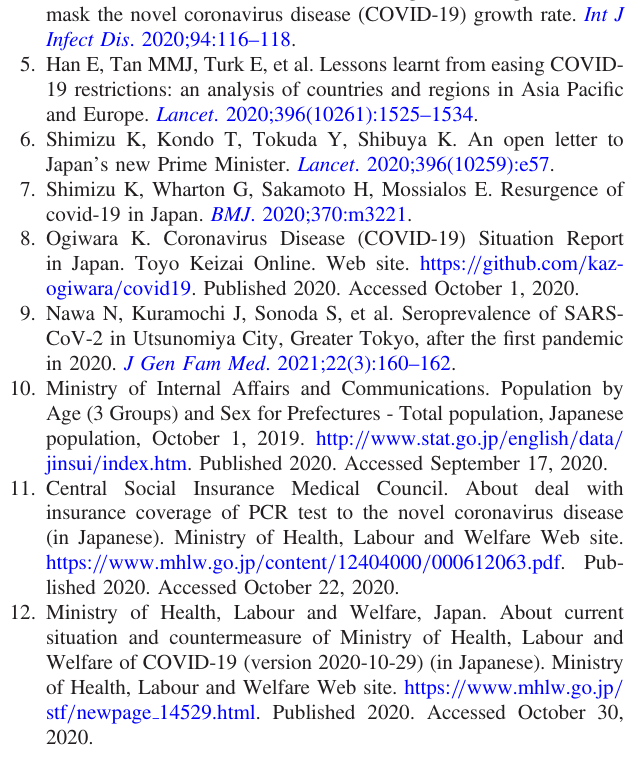
JPY, Japanese yen. + The total number of infected individuals was calculated by summing the numbers in each age group. Thus, this value was di ff erent from the product of the total population (126,173,000) and overall prevalence